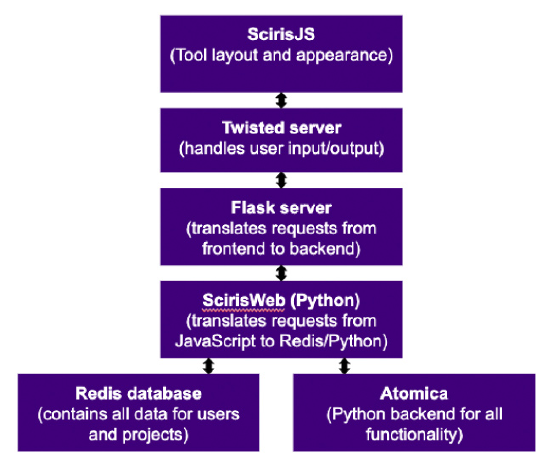
Figure 3. The software architecture of the Cascade Analysis Tool.